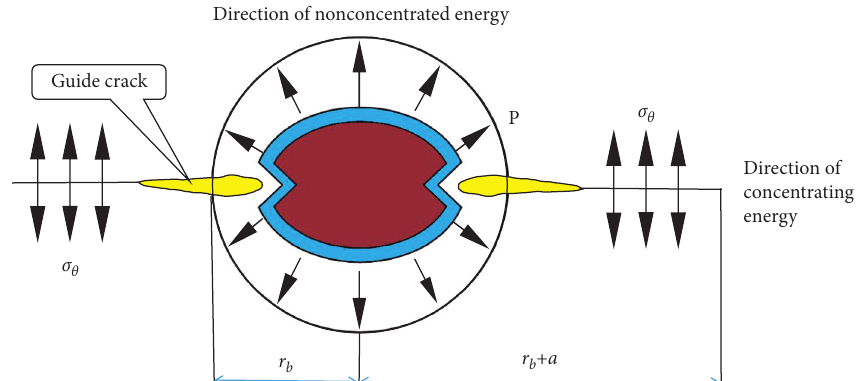
Figure 1: Mechanical model of cracking due to shaped charge blasting [23].